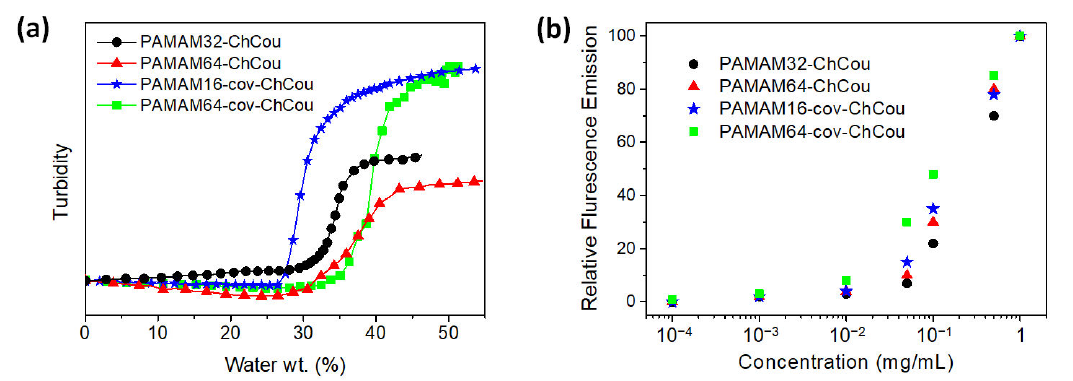
Figure 3. ( a ) Turbidity evolution (THF solutions versus amount of water added). ( b ) Fluorescence intensity of Nile Red at 606 nm (λ exc = 550 nm) versus dendrimer concentration.